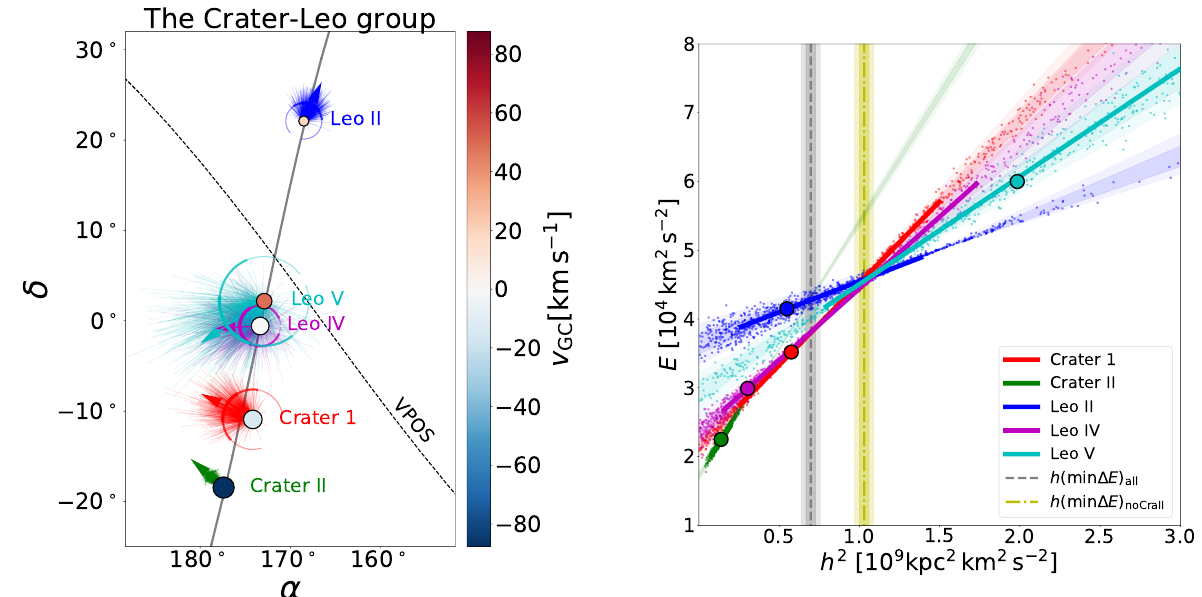
Figure 7. The proposed Crater–Leo group of MW satellite galaxies. The ( left-hand panel ) plots the on-sky positions of the five proposed group members in equatorial coordinates. They align along one great circle (solid grey line), which is inclined relative to the VPOS (dashed line). All satellites have relatively small galactocentric velocities v GC (color coding of symbols). Smaller symbols correspond to more distant satellites, highlighting the smooth distance gradient among the members from the ∼ 110kpc distant CraterII in the South to LeoII at ∼ 210kpc in the North. The thick arrows indicate the most likely direction of motion based on current proper motion estimates; the thinner arrows indicate Monte Carlo samplings from the proper motion uncertainties, and the circle segments indicate the 1, 2, and 3 σ uncertainties in the velocity directions of the satellites. The velocities are currently not sufficiently constrained to clearly judge a possible association. All but CraterII are currently consistent with moving along the direction defined by the proposed group, but all could also could also move along the VPOS similarly to CraterII. The ( right-hand panel ) plots the specific total energy E and square of the specific angular momentum h for the five proposed objects, assuming an MW potential containing a mass of 1.5 × 10 12 M (cid:12) within 250kpc. It is expected that satellites accreted as one group share similar energy and angular momentum. Within the current proper motion uncertainties (small dots indicate individual Monte Carlo sampled realizations of the observed data), Crater1, Leo II, Leo IV, and LeoV share very similar energy and angular momentum (the point of closest crossing of all four is indicated by the vertical yellow band). CraterII appears to be unassociated due to its much smaller energy and angular